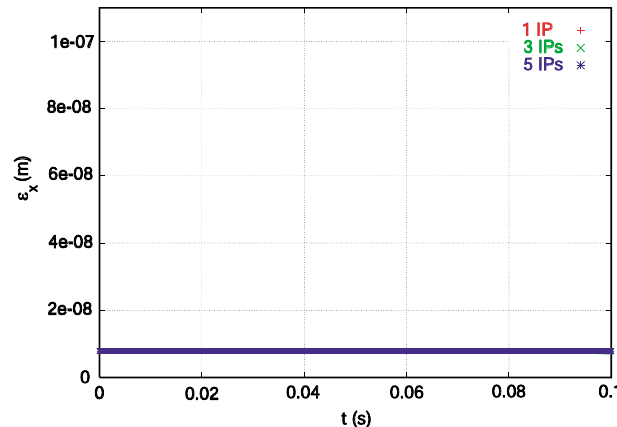
FIG. 81. (Color) Simulated evolution of LHC emittance versus (cid:3) 6 (cid:1) 10 11 m (cid:2) 3 when the beam and time in seconds for (cid:31) e electron macroparticles are perfectly symmetrized; the curves correspond to different numbers of electron-beam IPs [88].